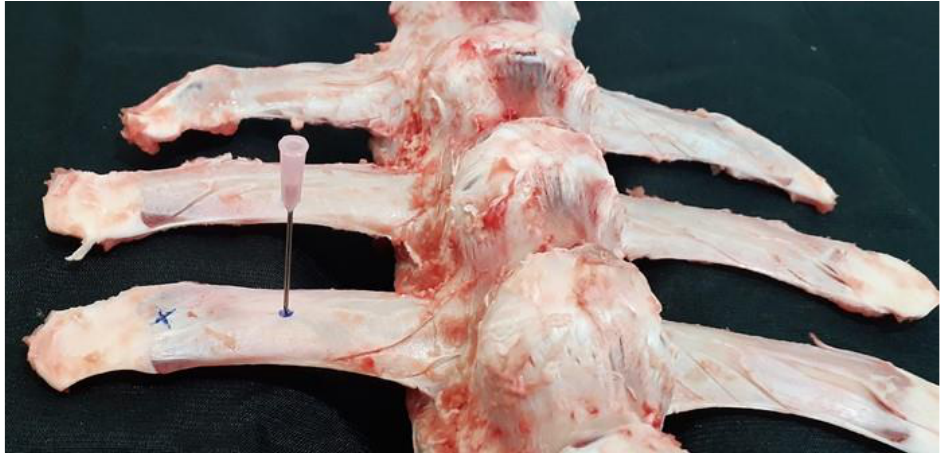
Figure 11. Needle inserted at the correct location for testing in the lumbar vertebrae, i.e., approximately half the length of the transverse process, and the more fragile (cartilaginous) end of the transverse process (X = incorrect test site) where if tested on a P-adequate animal would generate a false-positive result [11].